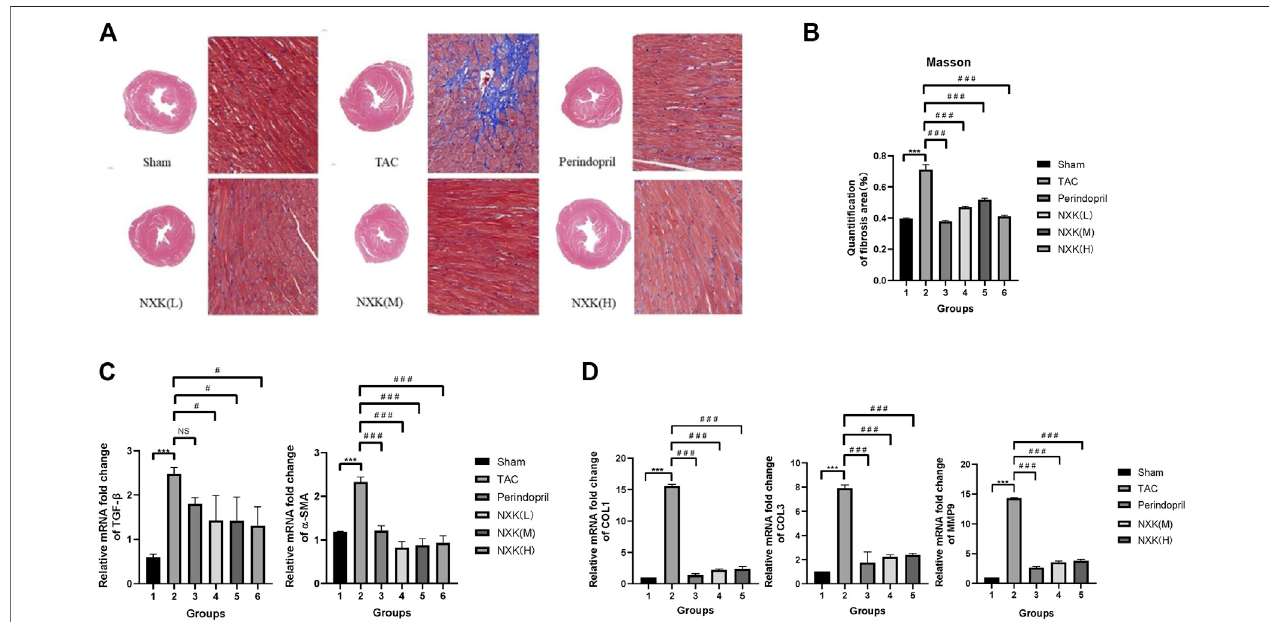
FIGURE 2 | The effect of NXK on myocardial fi brosis in mice with heart failure. (A) Myocardial fi brosis was evaluated through Masson ’ s Trichrome staining ( n = 10 pergroup).The fi broticareaisshowninblue. (B) Quanti fi cationof fi brosisareainthesham,TAC,low-,mid-andhigh-doseNXKgroups. (C) mRNAexpressionlevelsof α - SMA and TGF- β quanti fi ed by RT-PCR ( n = 10 per group). Quanti fi cation was performed after normalization to β -actin. (D) mRNA expression levels of Col1, Col3, and MMP9 quanti fi edbyRT-PCR( n =6).Quanti fi cation wasperformedafter normalizationtoGAPDH.Valuesareshownasmeans±SD,compared totheshamgroup * p < 0.05, ** p < 0.01, *** p < 0.001, compared to the Tac group # p < 0.05, ## p < 0.01, ### p <